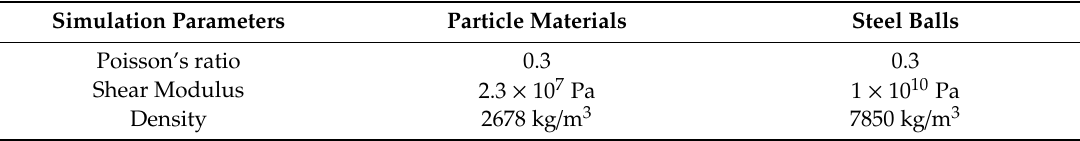
Table 1. Simulation conditions of discrete element method (DEM).